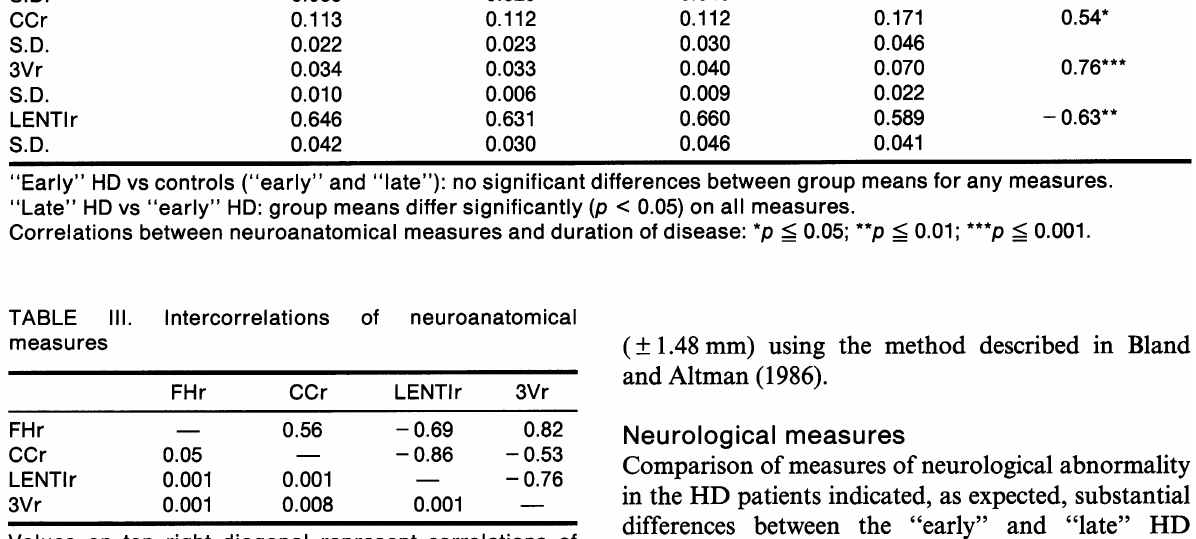
TABLE II. Group means and standard deviations (S.D.) of the neuroanatomical measures of the HO patients Group "Early" "Late" "Early" "Late" Correlation of control control HO HO CT measures with FHr 0.312